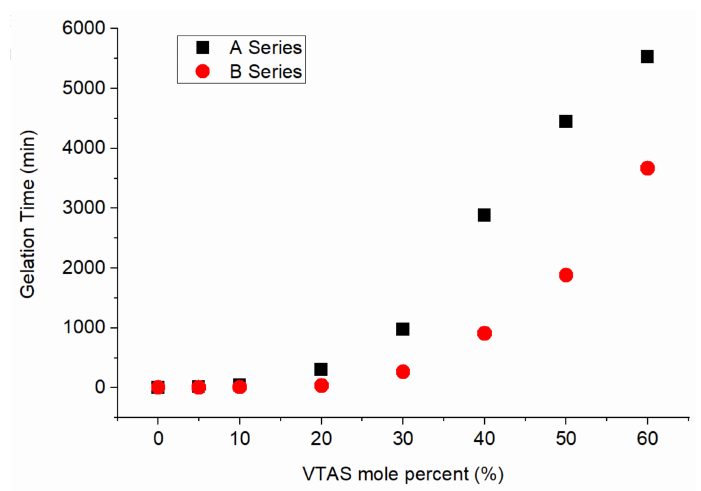
Figure 2. Evolution of the gelation time when using different molar ratios of precursors and NaF (A Series) or NH 4 F (B Series)